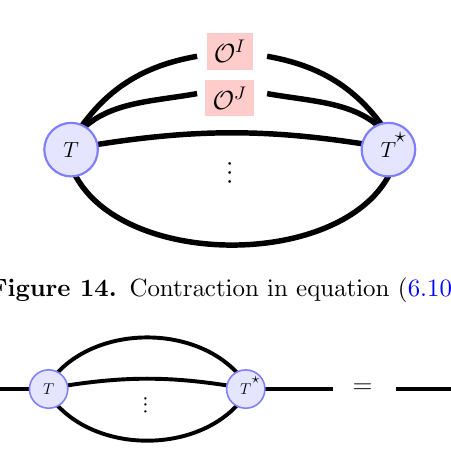
Figure 15. Consistency condition